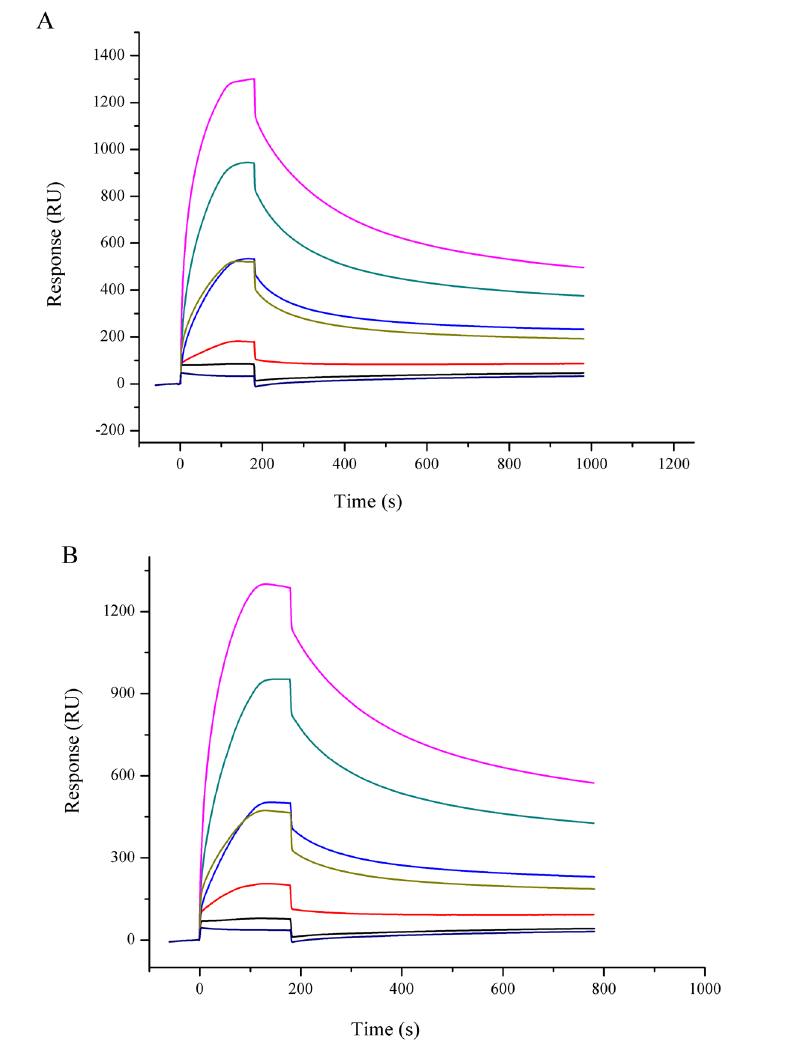
Figure 2. Binding sensorgram of Hsp90 with PAPC (A) and PAPC hydroperoxide (B) by SPR. A series concentration of Hsp90 (0.14 to 2.22 μM) were injected on the chip loaded with liposome. Hsp90 rapidly attained equilibrium binding and showed dose-dependent responses. Hsp90, 90 Kda